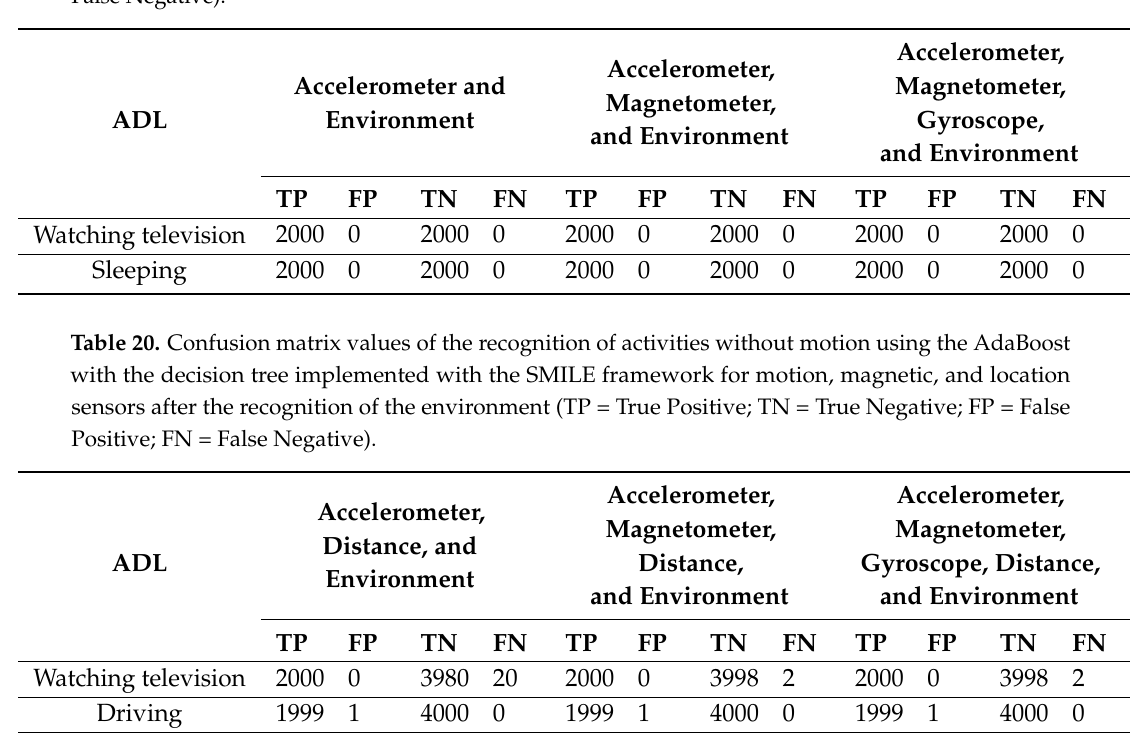
Table 19. Confusion matrix values of the recognition of activities without motion using the AdaBoost with the decision tree implemented with the SMILE framework for motion and magnetic sensors after the recognition of the environment (TP = True Positive; TN = True Negative; FP = False Positive; FN = False Negative).